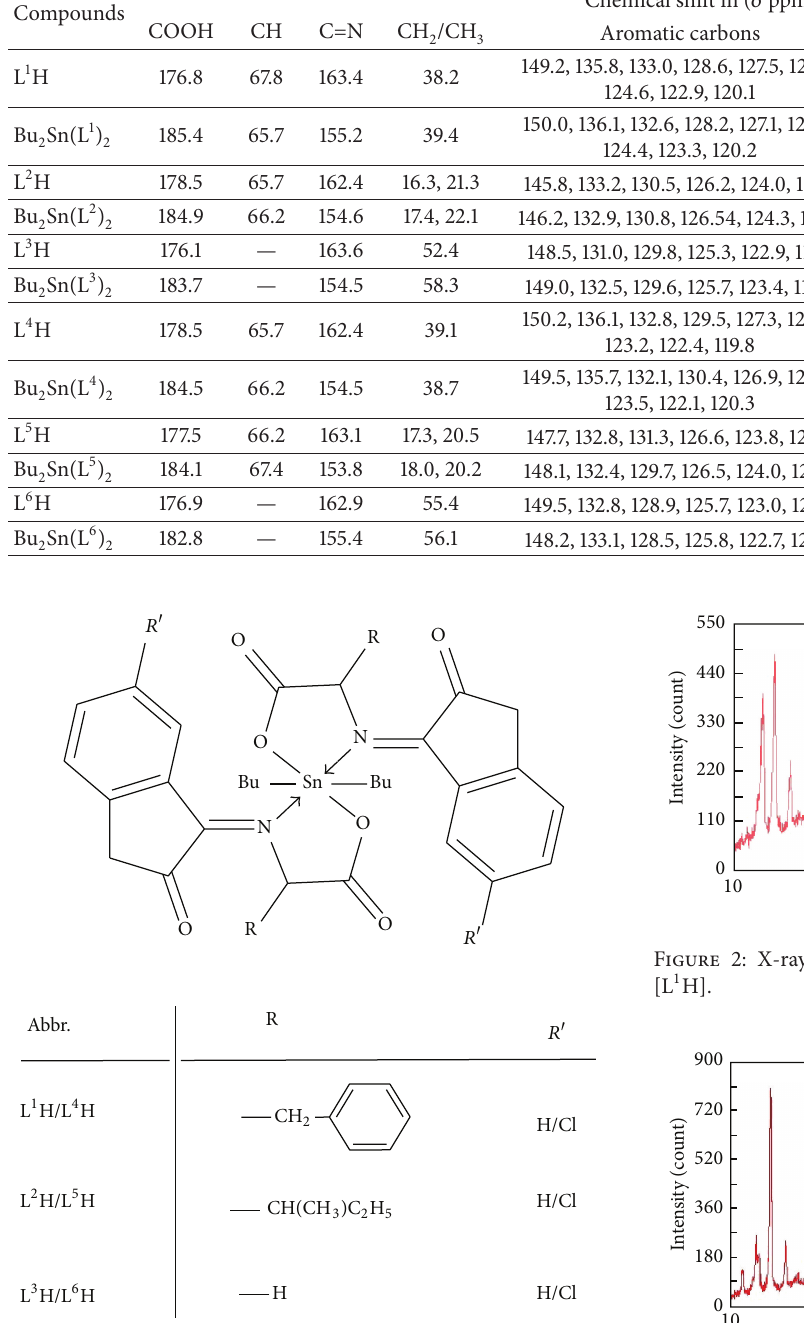
Figure 1: Structure of diorganotin(IV) complexes. print of three dimensional arrangements of atoms. Beside